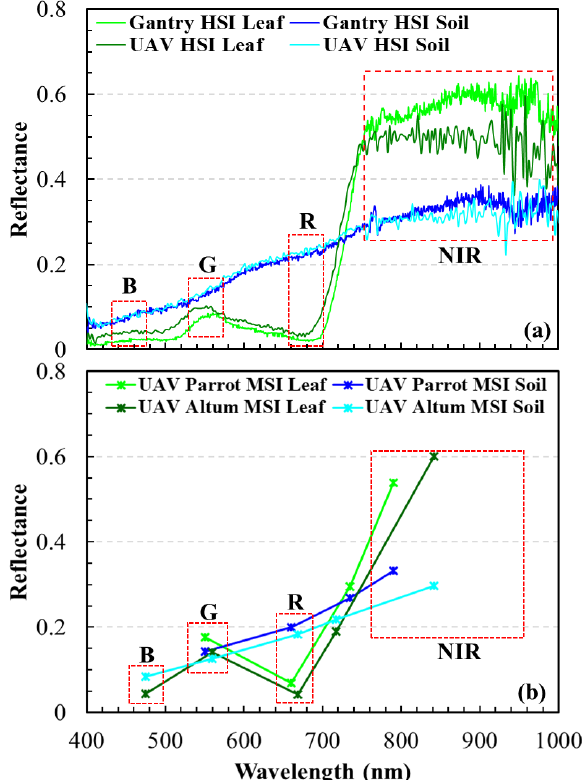
Figure 2. Spectral profiles of green vegetation and soil extracted from hyperspectral (a) and multispectral imagery